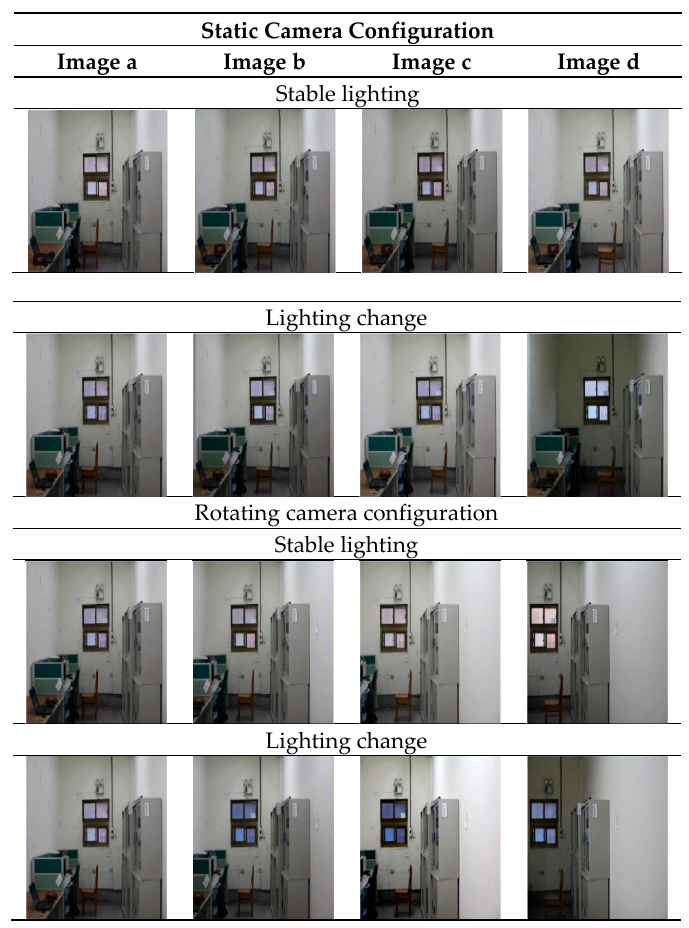
Figure 6. A fraction of the image sequence.